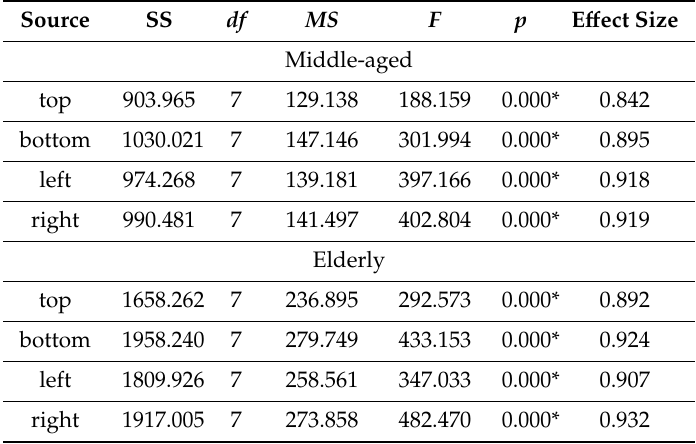
Table 4. Interaction between presentation positions and button size.